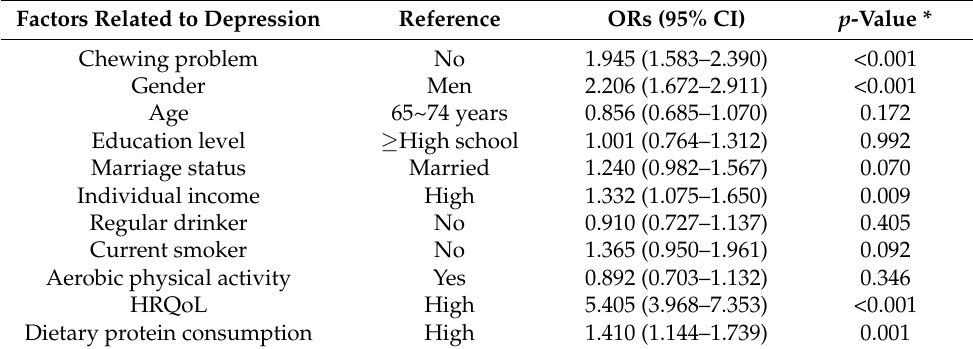
Table 4. Factors related to depression by chewing problems in elderly